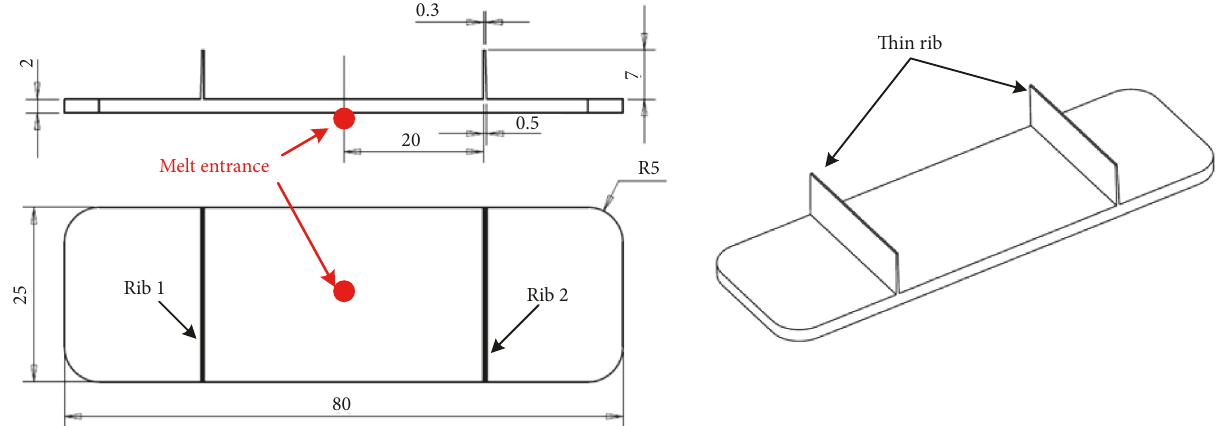
Figure 8: Thin rib